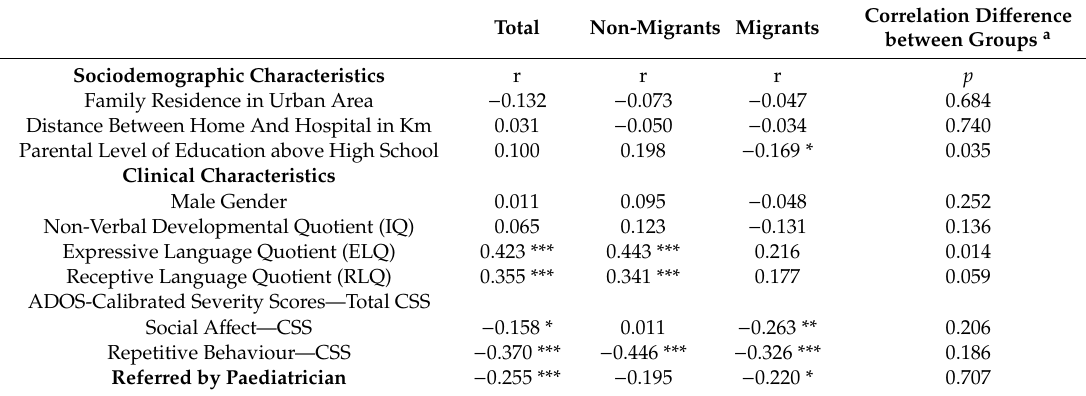
Table 2. Correlations between sample characteristics and age at diagnosis separated by migration